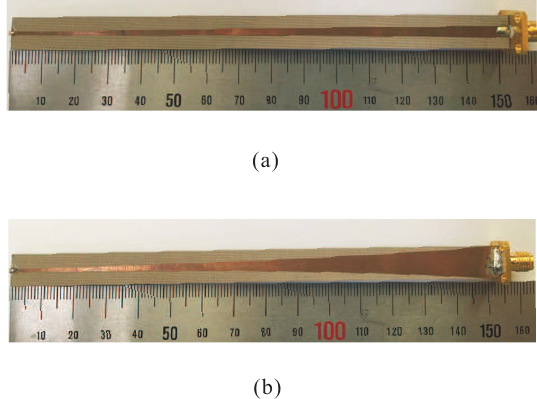
Figure 5. Photographs of the proposed balun: ( a ) Top side; ( b ) Bottom side.